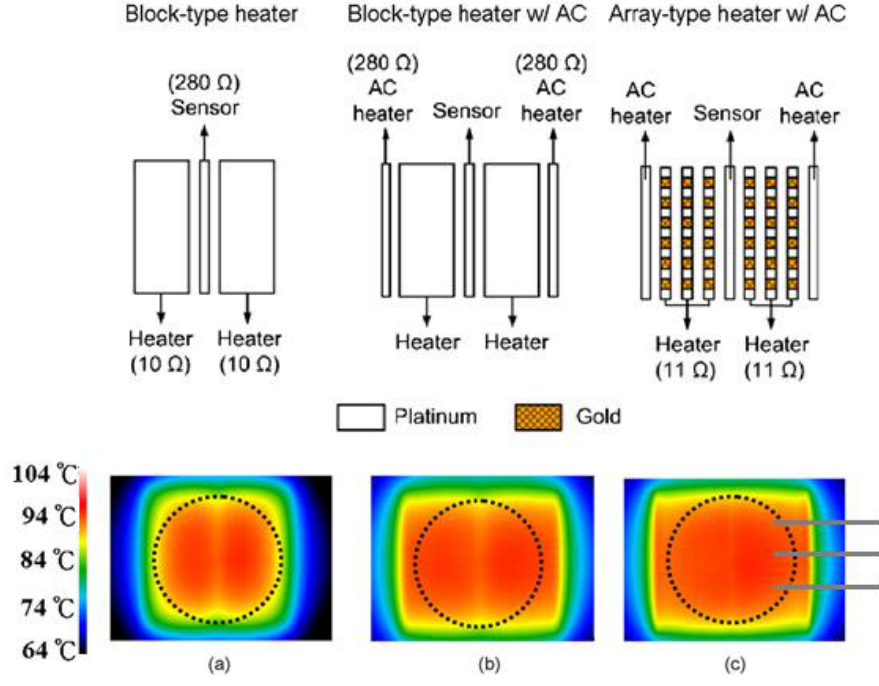
Figure 12. Infrared images of each microthermal cycler without heat sinks at the denaturing temperature. ( a ) 2-D temperature profile of the block-type microheaters. ( b ) 2-D temperature profile of the block-type microheaters with additional side heaters by applying an AC field. ( c ) 2-D temperature profile of the array-type microheaters with AC units. The dotted line shows the location of the PCR reaction chamber. The dimensions of each block in (a) are 2,900 µm × 6,000 µm, which are divided into grids (100 µm × 100 µm) with a spacing of 100 µm in (c). Reprinted from [12], Copyright 2008, with permission from